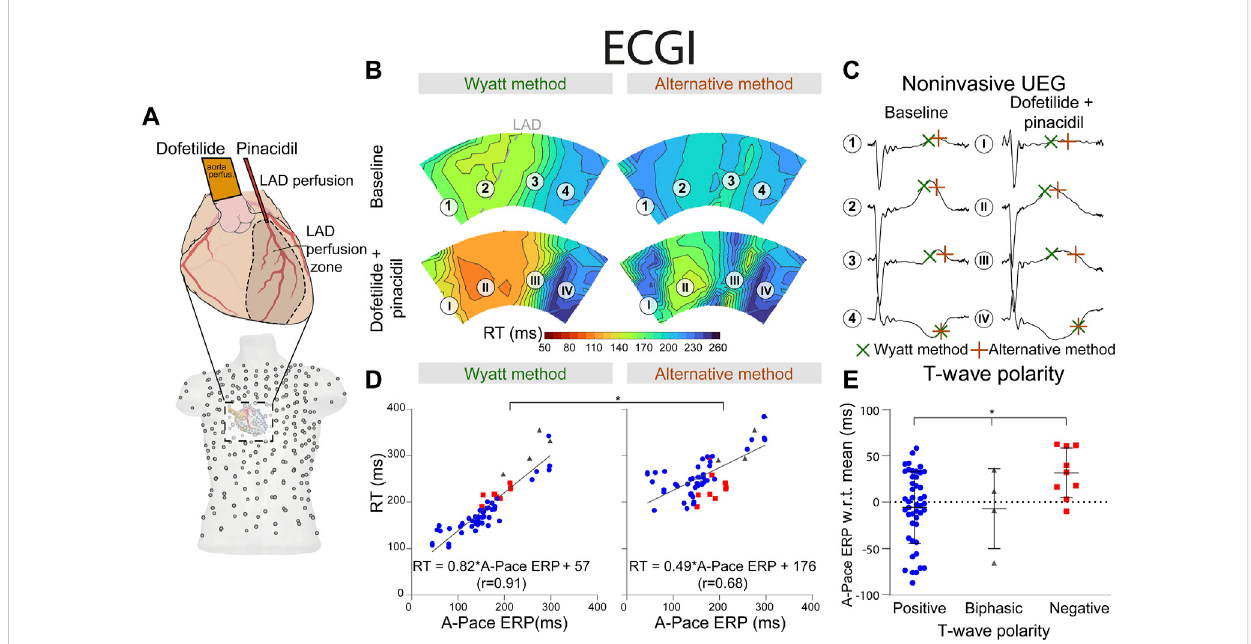
FIGURE 5 RT determined by the Wyatt and alternative method through non-invasive ECGI. (A) experimental setup, similar to the setup in Figure 3. The explanted heart was placed in a torso-shaped tank fi lled with blood. (B) RT as determined by the Wyatt and alternative methods before and after drug infusion. (C) electrograms corresponding to different locations in (B) . (D) linear regression when comparing A-pace ERP (see text) to RT determined by boththeWyattandalternativemethod.PositiveT-wavesareshowninblue,biphasicT-wavesingray,andnegativeT-wavesinred. (E) A-paceERPof positive, biphasic and negative ECGI T-waves, with respect to the mean A-pace ERP of the same experiment. Figures (D,E) show pooled data of all our experiments with different drug